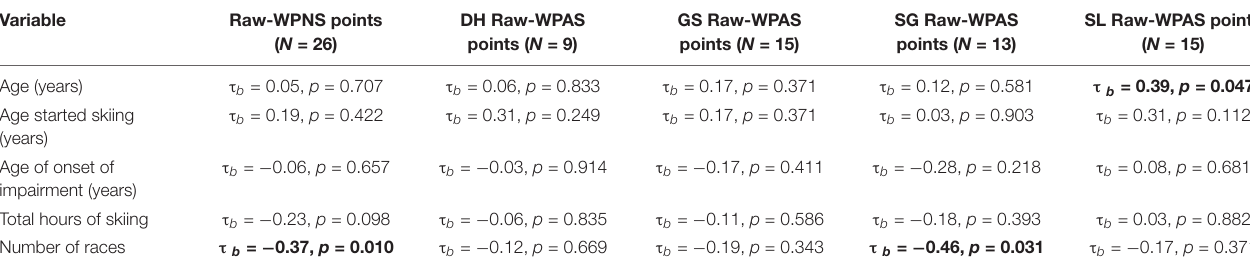
TABLE 6 | Summary of correlations of non-vision variables with skiing